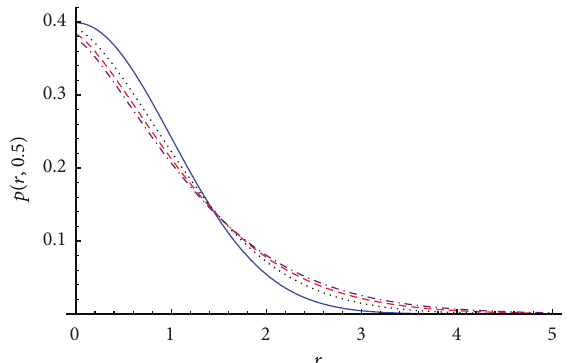
Figure 2: Curves of 𝑝(𝑟, 0.5) versus 𝑟 for 𝑑 𝑓 = 1 and for 𝑑 𝑤 = 2 (solid line), 𝑑 𝑤 = 2.5 (dot line), 𝑑 𝑤 = 3 (dash line), and 𝑑 𝑤 = 3.5 (dot-dash line).